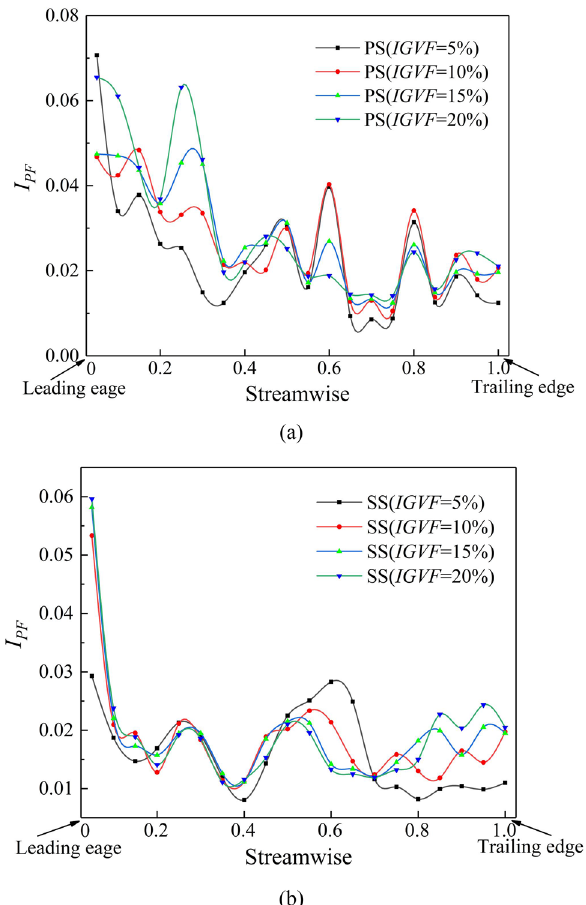
Figure 13. Pressure fluctuation intensity on the blade. ( a ) Pressure fluctuation intensity on the PS and ( b ) Pressure fluctuation intensity on the